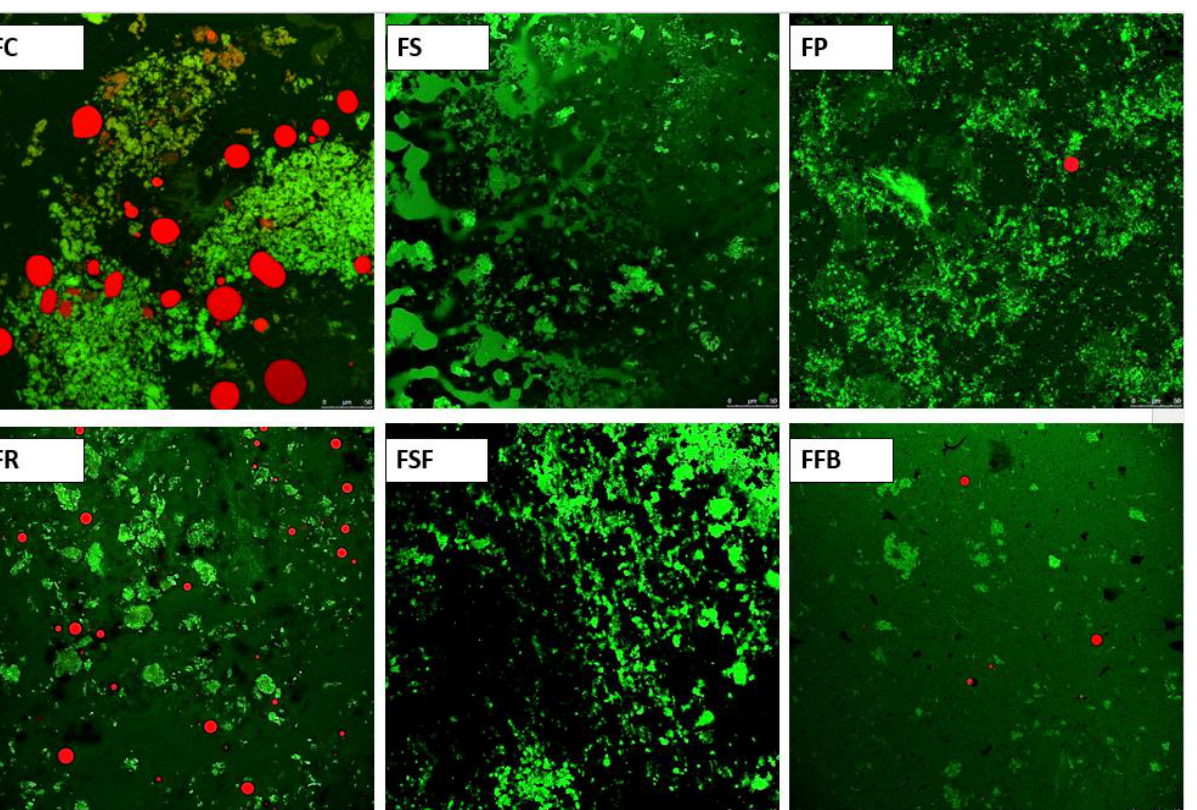
Figure 8. Confocal scanning laser microscopy images of hybrid meat emulsions after in vitro simu- lated digestibility. Magnification: 40×; Scale bar: 50 µm. FC: control; FS: soy; FP: pea; FR: rice; FSF: sunflower; FFB: fava bean.